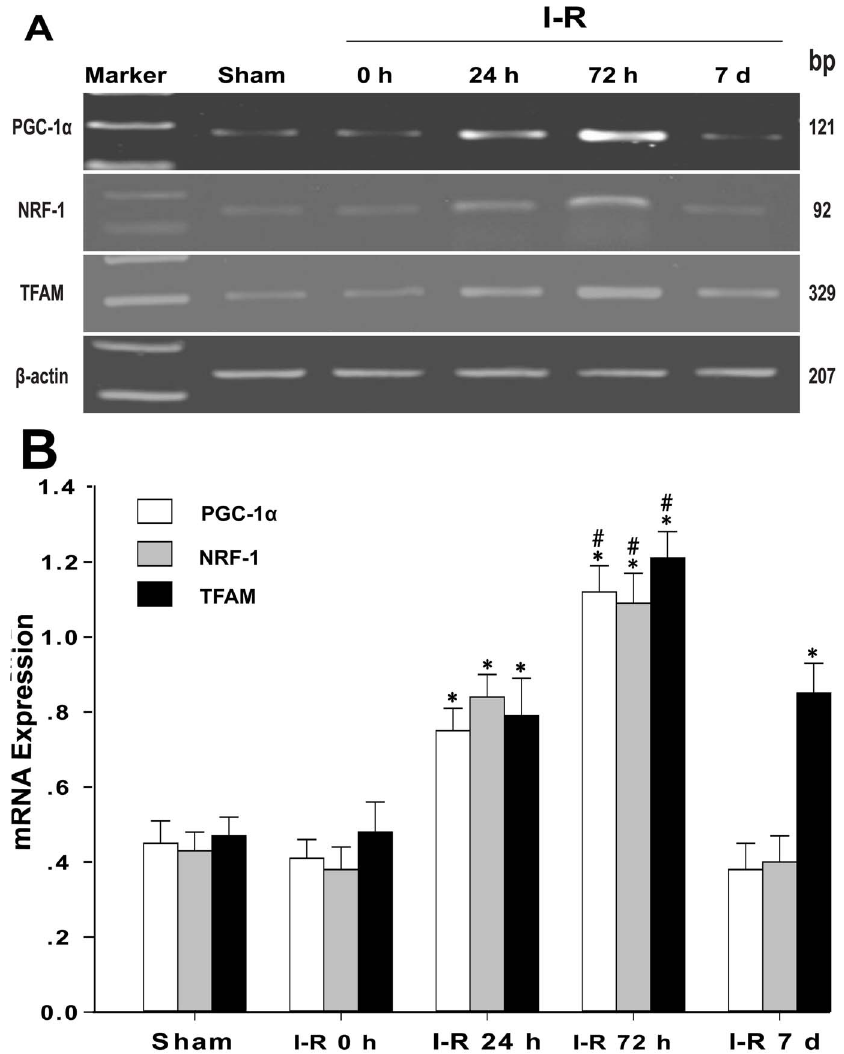
Figure 3. mRNA expression of the mitochondrial biogenesis factors in the cortex. (A) Representative agarose gel of PGC-1 a , NRF-1, and TFAM RT-PCR products prepared from the mRNA of the sham group or the I-R 0 h, I-R 24 h, I-R 72 h, and I-R 7 d groups. (B) The histogram shows the semi-quantitative measurement of the PCR products in (A), which were obtained using densitometric analysis. The data are expressed as the means 6 SD. *P , 0.05 versus the I-R 0 h and sham groups; # P , 0.05 versus the I-R 24 h and I-R 7 d groups.